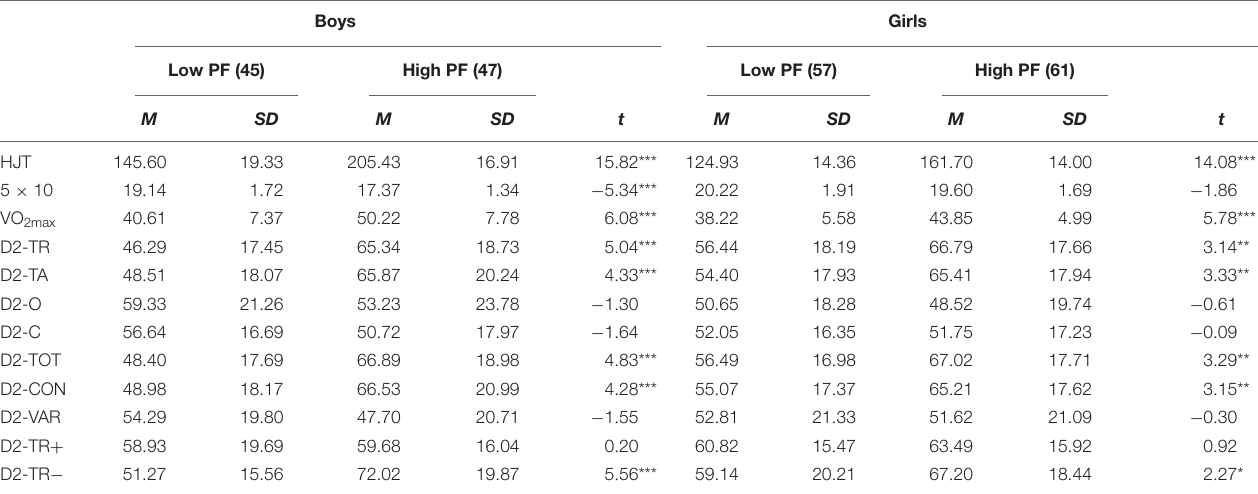
TABLE 4 | Descriptive statistics of study variables analyzed by cluster and differences among groups ( t